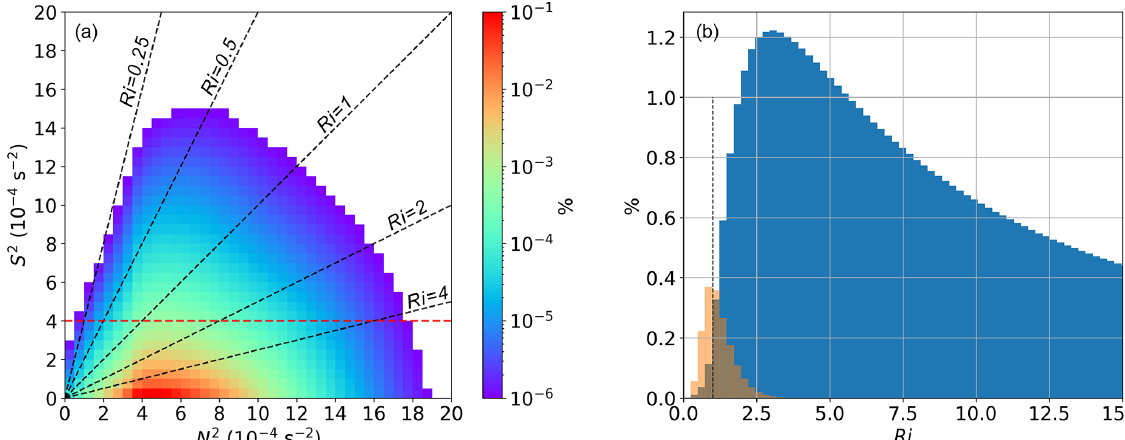
Figure 14. (a) Relative occurrence frequency distribution of N 2 – S 2 pairs in the region between the LRT and 3km above for all daily northern hemispheric ERA5 fields from 2008–2017. Logarithmic occurrence frequency color scale. Dashed red line indicates S 2 = S 2 t . Dashed black lines indicate the Richardson numbers 0.25, 0.5, 1.0, 2.0, and 4.0. (b) Histogram of the relative distribution of Richardson numbers associated with the data displayed in panel (a) . Orange bars show Ri for grid volumes with S 2 ≥ S 2 t , and blue bars for the remaining grid volumes between the LRT and 3km above. Dotted black line indicates Ri =